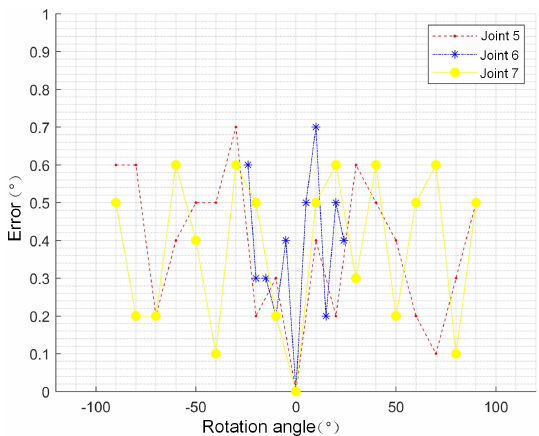
Figure 11. The error of the rotation angle of the joints.